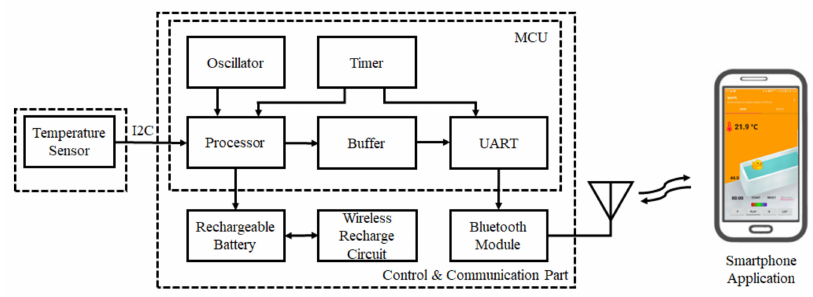
Figure 4. Block diagram of the proposed smart bath assistive device connected with a smartphone by